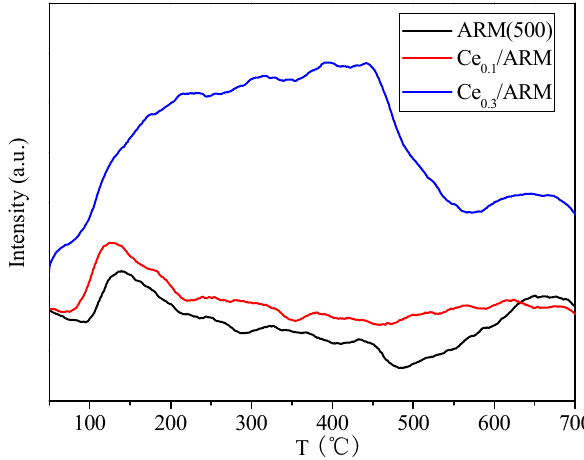
Figure 6. The NH 3 ‐ Temperature Programmed Desorption (TPD) curves of Ce 0.3 /ARM, Ce 0.1 /ARM and ARM(500).